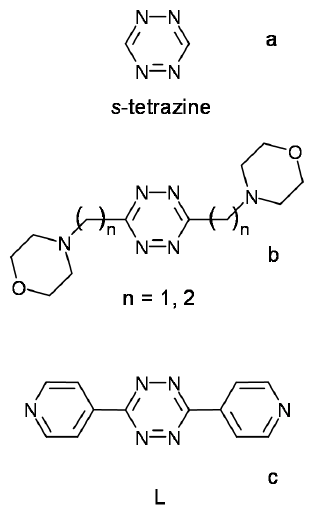
Figure 1. ( a ) s -Tetrazine and ( b ) its morpholine and ( c ) pyridine